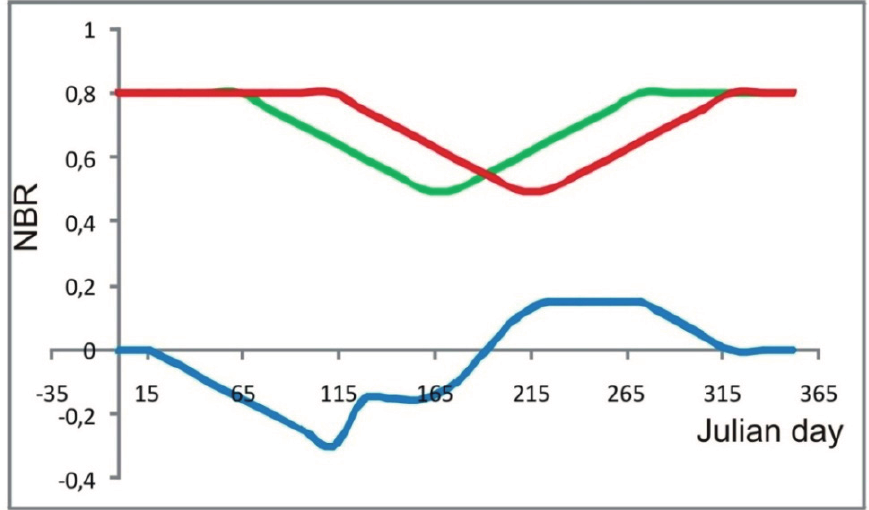
Figure 20. Baseline-adjustment error from the delay of the dry season, where the green line is the time series, the red line is the time series in a previous year, and the blue line isa subtraction between the two. The high NBR values are incompatible with burned areas, although the seasonal difference presents a significant decrease of